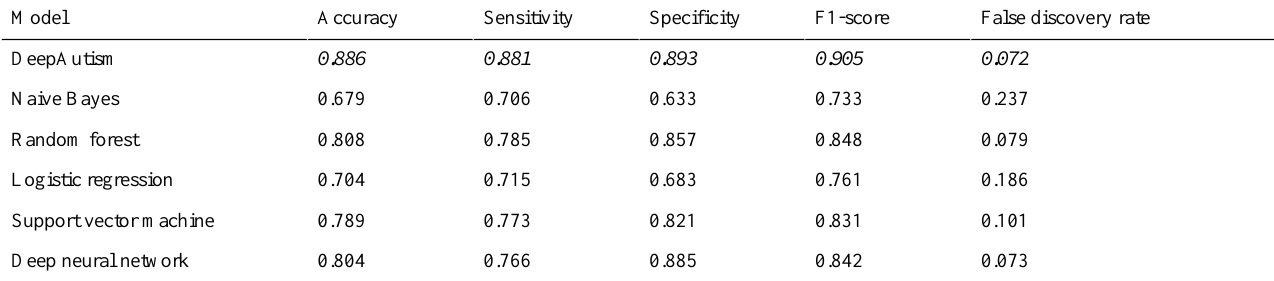
False discovery